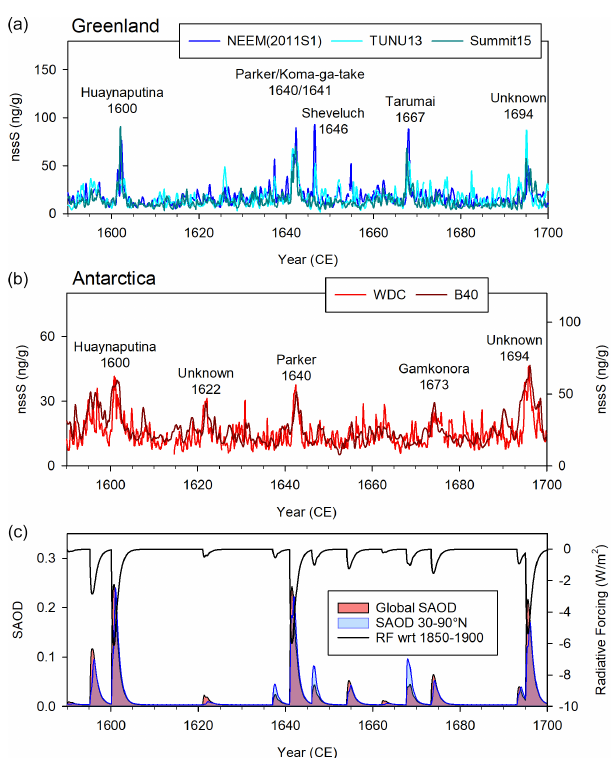
Figure 2. Monthly non-sea-salt sulfur records from ice cores in Greenland and Antarctica, SAOD, and radiative forcing during the 17th century (Toohey and Sigl,